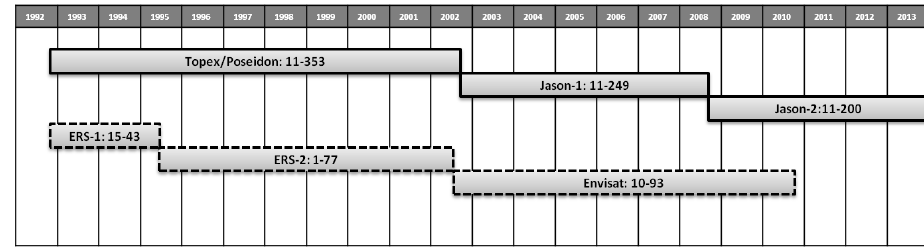
Figure 1. Altimeter long-term time series used in the